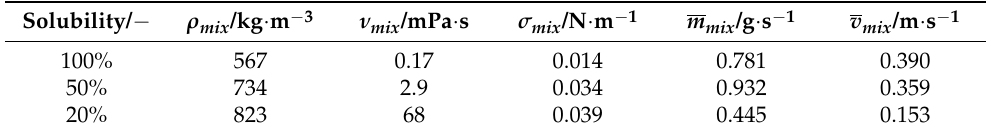
Table 3. Liquid-return characteristics in the liquid-return holes with different refrigerant solubility.